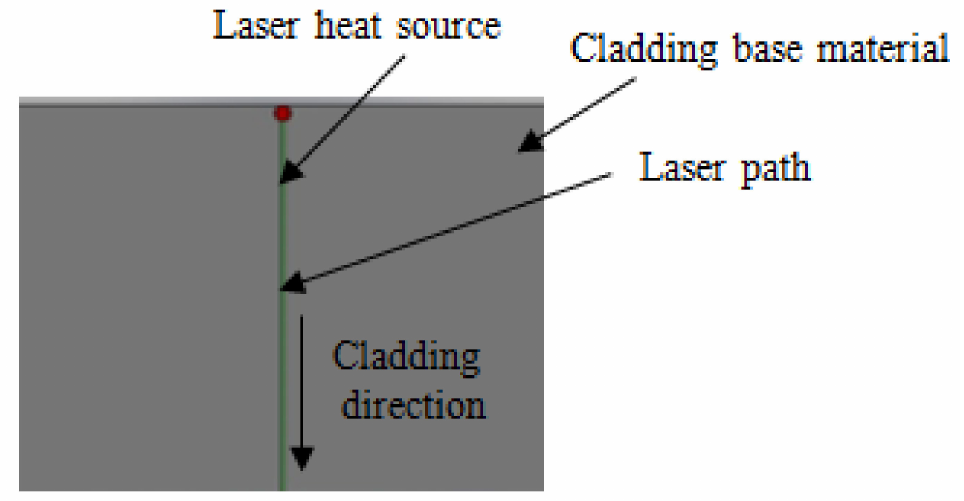
Figure 4. Laser heat source loading